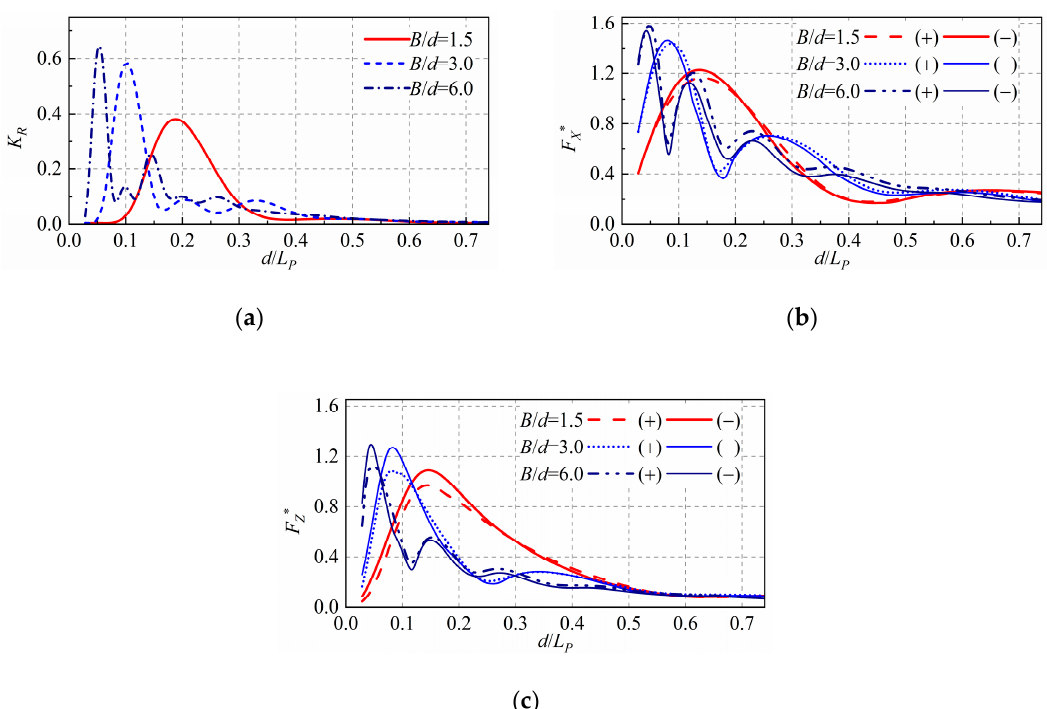
Figure 7. Variations of reflection coe ffi cients and wave forces about the ratio of water depth to wave length d / L P with di ff erent relative breadth: ( a ) reflection coe ffi cient, ( b ) horizontal force and ( c ) vertical force.